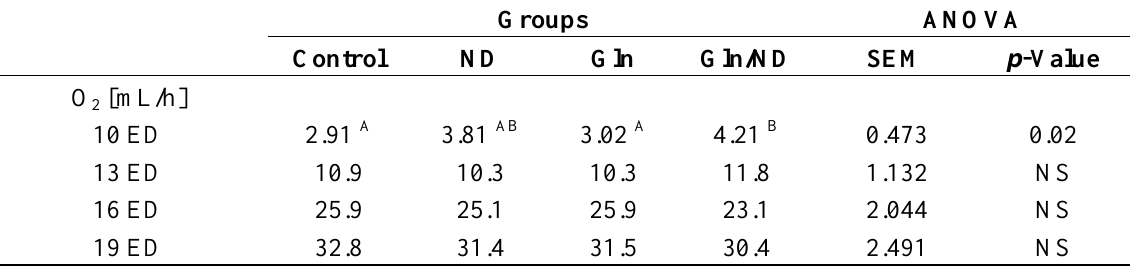
Table 3. Oxygen consumption (O ) in the control group and groups treated with 2 nanoparticles of diamond (ND), L -glutamine (Gln), and bio-complex of Gln with ND (Gln/ND), n = 40/group. Groups